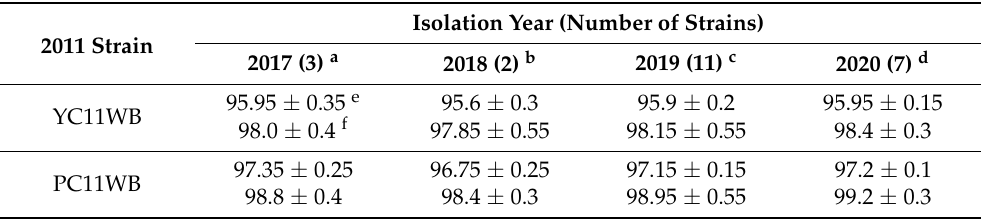
Table 2. Comparison of E2 gene nucleotide and amino acid sequence homologies between wild Korean boar CSFVs isolated from 2017–2020 and two CSFV strains identified in 2011.